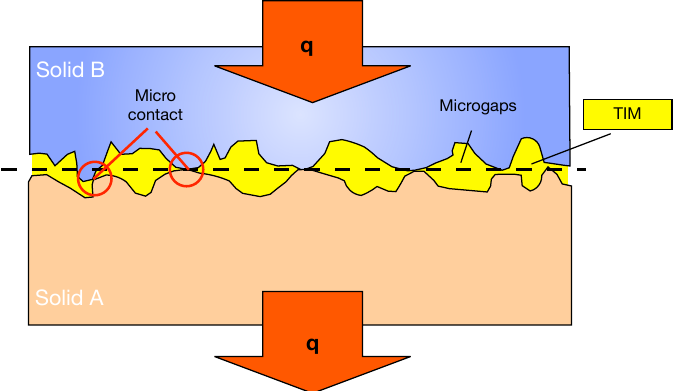
Figure 4. General thermal contact illustration and the schematic temperature distribution along the two bodies’ contact